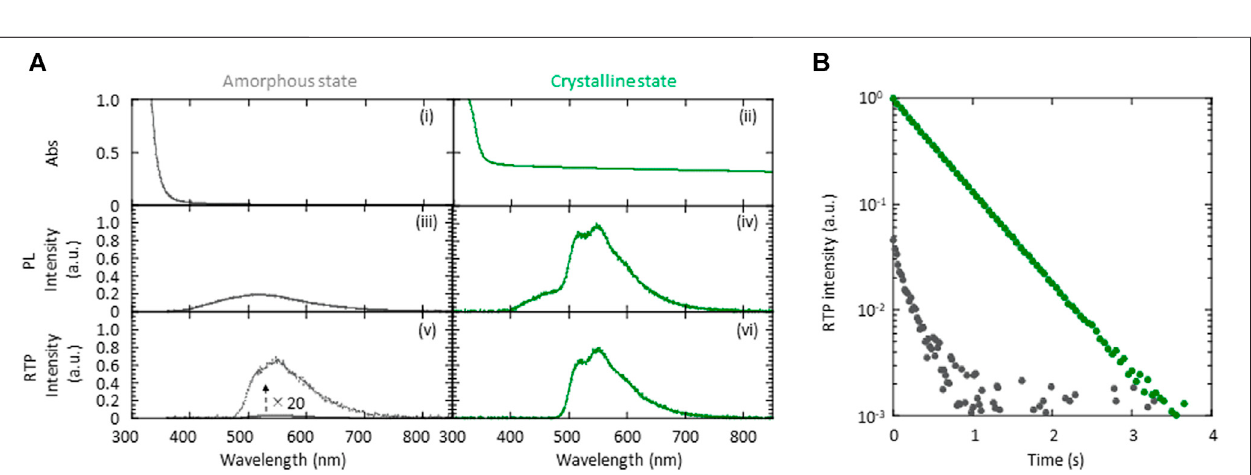
FIGURE2| Absorptionandemissioncharacteristics of5 wt%( S )-BINAP-doped ( S )-H 8 -BINAP fi lms. (A) Absorption(i,ii),steady-stateRTemission (iii,iv),andRTP (v, vi) spectra of amorphous (gray) and crystalline (green) fi lms. (B) RTP decay characteristics of amorphous (gray) and crystalline (green) fi lms. The RTP intensity immediately after ceasing excitation in the crystalline state was normalized to one and the initial intensity of RTP immediately after ceasing excitation in the amorphous state was set by considering the difference in Φ p (RT) between the crystalline and amorphous states. In (A) and (B) , the excitation wavelength used for emission measurements was 330 nm. (RT (cid:1) room-temperature; RTP (cid:1) room-temperature phosphorescence; ( S )-BINAP (cid:1) ( S )-( − )-2,2 ′ -bis(diphenylphosphino)-1,1 ′ -binaphthyl ( S )-H 8 -BINAP (cid:1) ( S )-bis(diphenylphosphino)-5,5 ′ ,6,6 ′ ,7,7 ′ ,8,8 ′ -octahydro-1,1 ′ -binaphthyl).